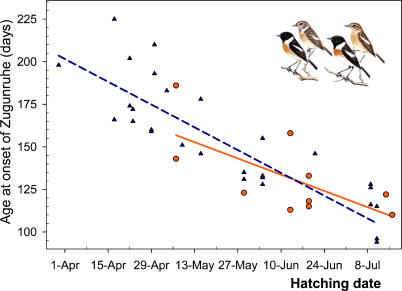
Relationship between Onset of Zugunruhe and Hatching DateAfrican resident (orange dots, solid regression line;
n = 10) and European migrant (blue triangles, dashed regression line;
n = 26) stonechats initiated Zugunruhe at progressively younger ages when hatched late in the season under European day length conditions. Inlay: pairs of African (right) and European (left) stonechats; females are less conspicuously colored than males. Drawing is by H. Kacher.